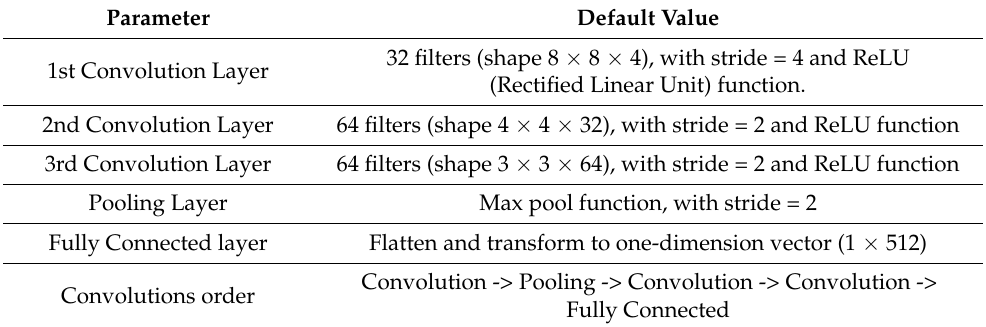
Table 6. CNN parameter